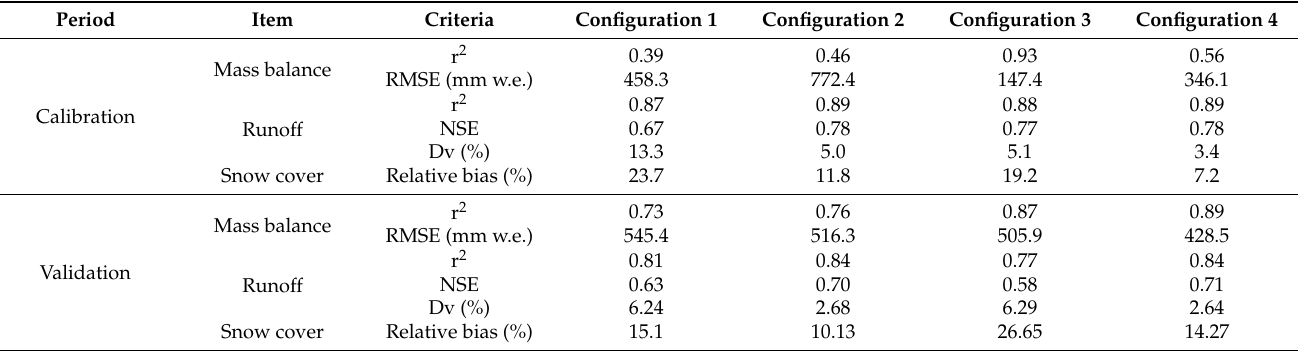
Table 2. Statistical results of model performance during model calibration, validation, and the whole period at the Kyanjing River